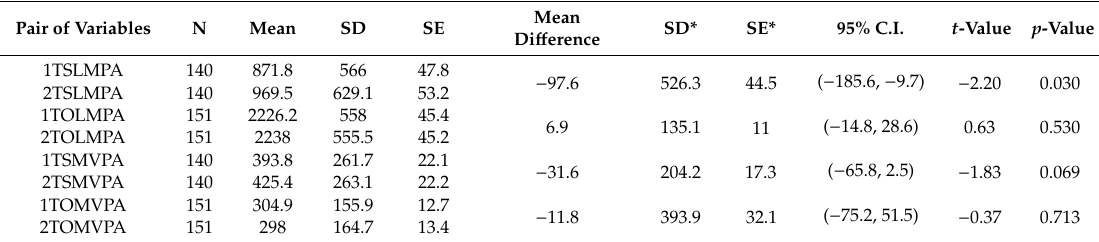
Table 2. Comparison of self-reported and accelerometer-based reports of PA levels, by trimester of